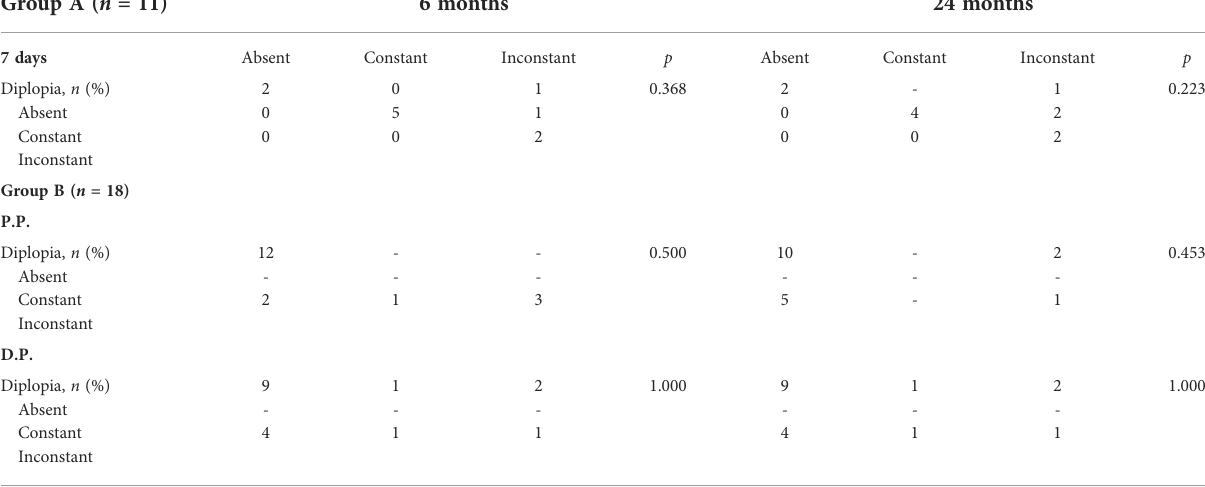
TABLE 3 Changes in diplopia at 6 and 24 months as compared to 7 days after surgery in the two subgroups ( n = 29). Group A ( n = 11) 6